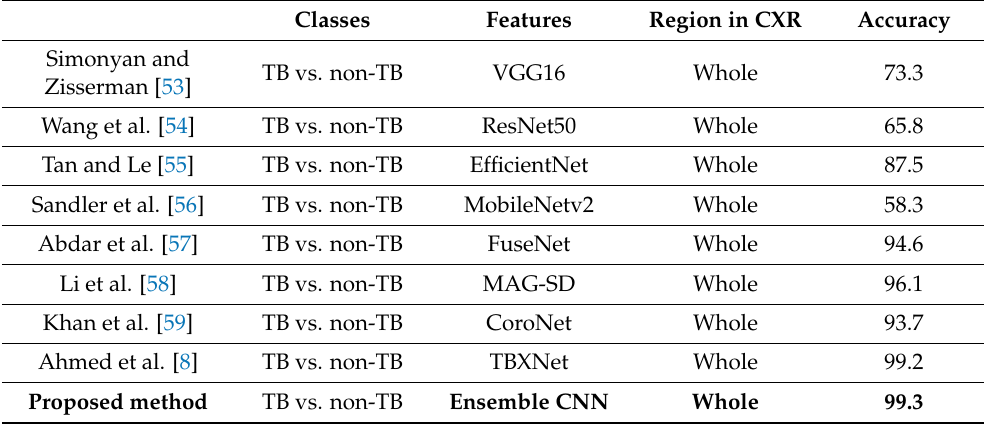
Table 6. The accuracy of the proposed methods with the existing heuristics to classify TB and Non-TB (Dataset